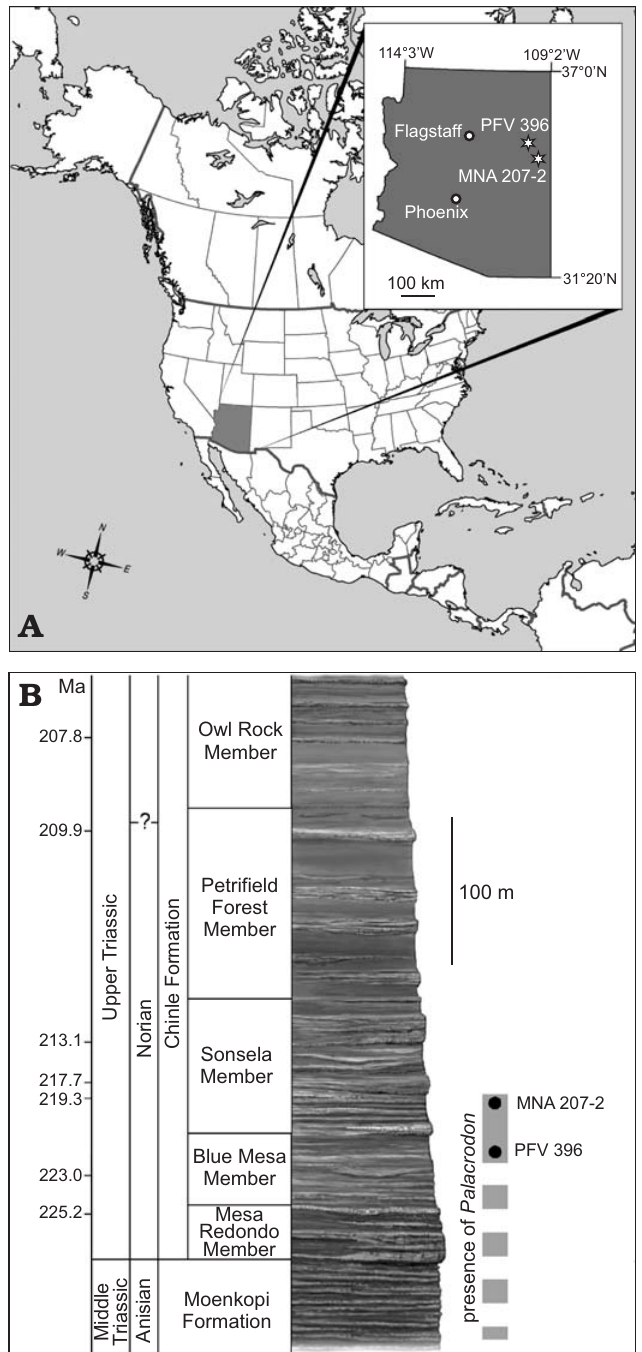
Fig. 1. Geographic and stratigraphic context of Palacrodon occurrences in Arizona. A . Map of Arizona showing the locations of PFV 396 and MNA 207-2. Map of North America modified from www.lakodosajta.info. B . Stratigraphic chart of the Chinle Formation at PEFO and the Placerias Quarry, with detrital zircon dates from Ramezani et al.